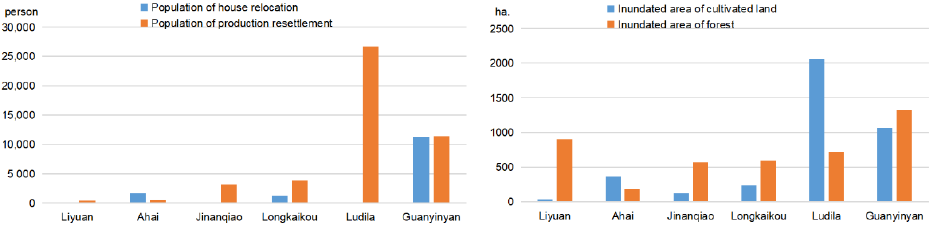
Figure 7. Number of resettled populations and inundated land areas for cascade hydropower development on the middle reach of Jinsha River.